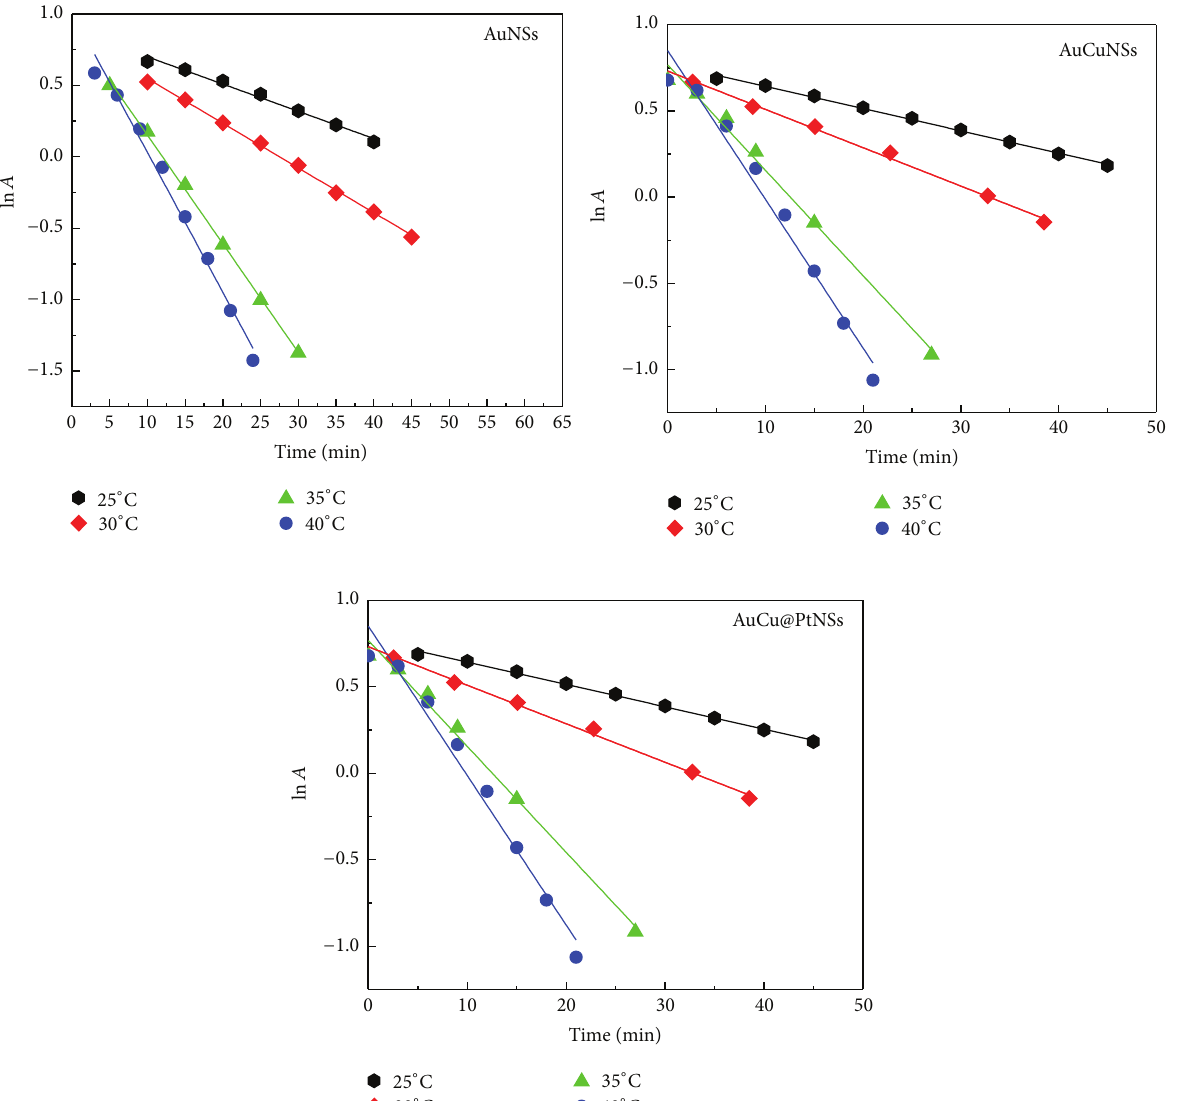
Figure 3: Kinetics of 4-NP reduction process assisted by nanocatalysts at 25 ∘ C (black, hexagon), 30 ∘ C (red, diamond), 35 ∘ C (green, triangle), and 40 ∘ C (blue,